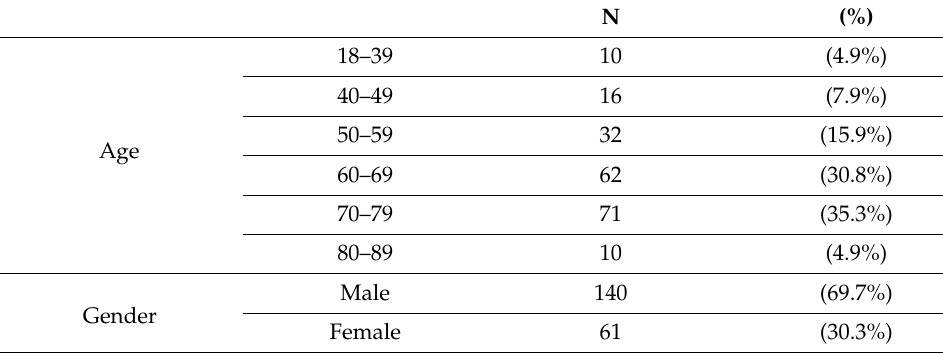
Table 1. Sociodemographic features of study